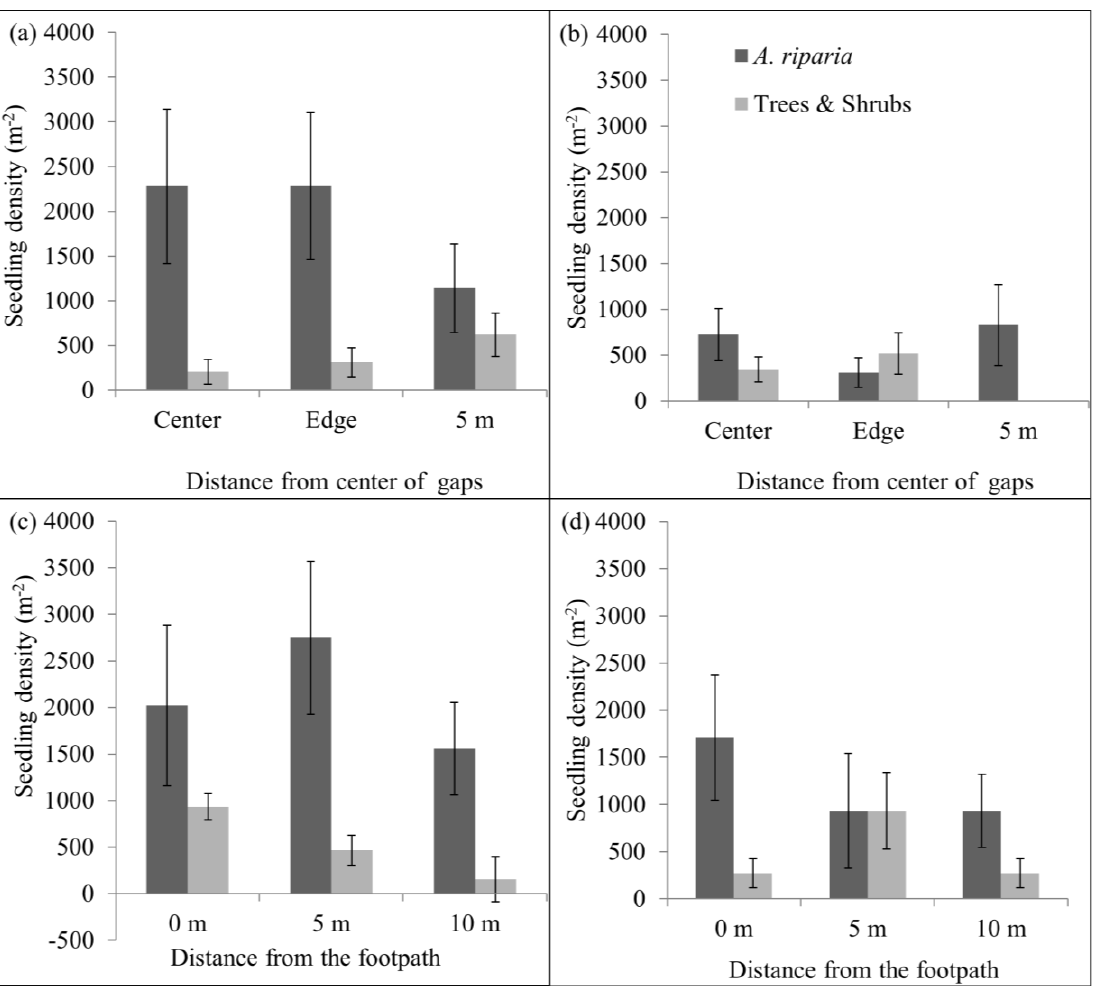
Figure 5: (a) The graph of seedling density vs. the distance from the forest gaps during the dry season (b) The graph of the seedling density vs. the distance from the forest gaps during the wet season (c) The graph of the seedling density vs. the distance from the footpaths during the dry season (d) The graph of the seedling density vs. the distance from the footpaths during the wet